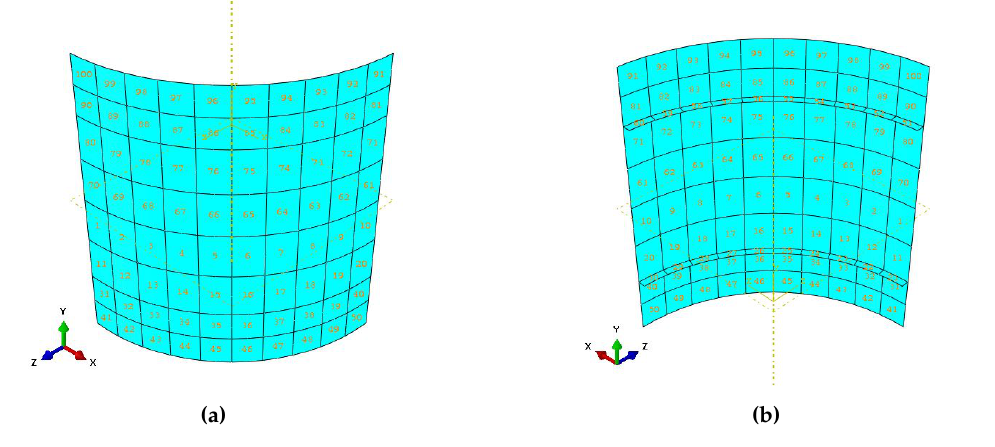
Figure 6. Stiffened fuselage section problem: ( a ) external and ( b ) internal views of the macroscale space discretization.